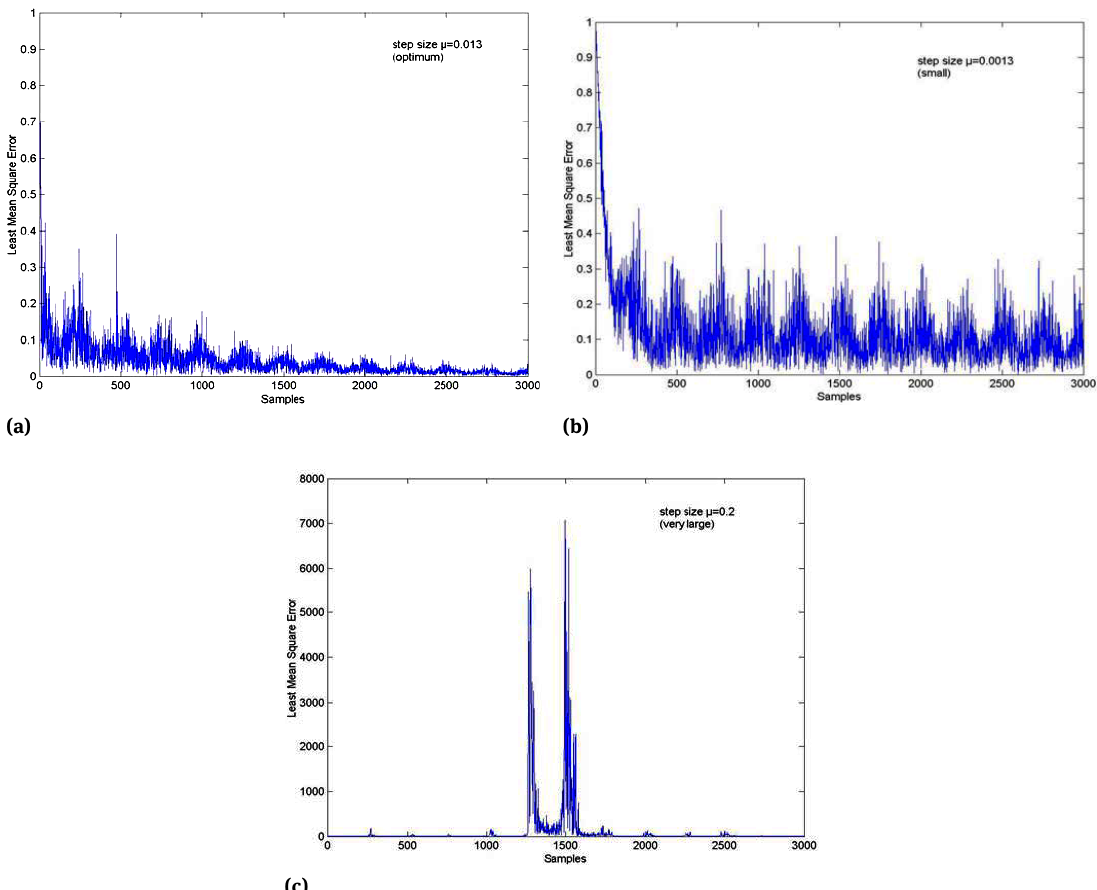
Figure 2: (a) shows the LMS error for µ = 0.013, this value of µ falls under the specified limit, hence displaying a decent conver- gence. (b) shows the LMS error for µ = 0.0013, this value of µ is small, so the rate of convergence is slow and it’s not converged after 3000 samples also, and when when µ = 0.2 the LMS error is erratic as shown in